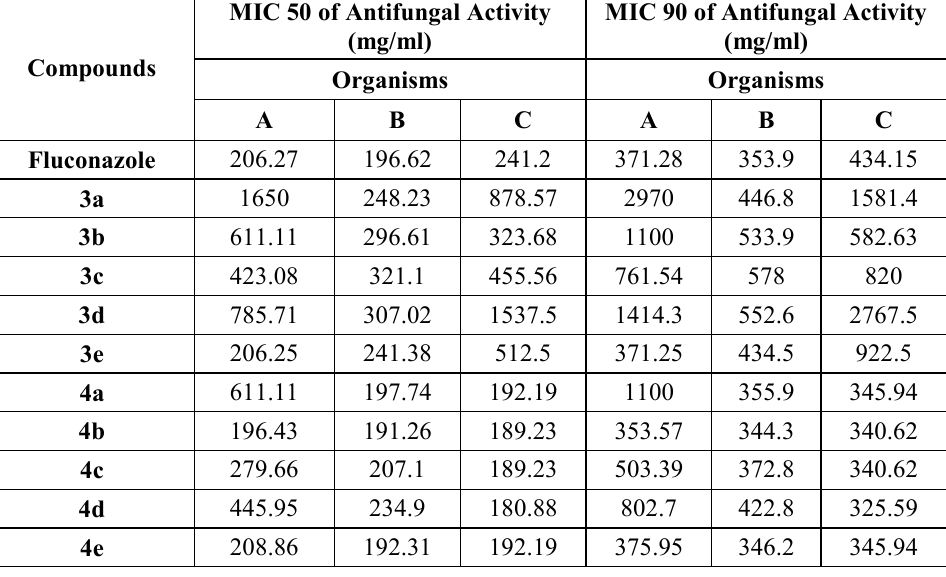
Table 5: Minimum inhibitory concentration (MIC) values (MIC50 & MIC90) of Most Potent compounds measured against three fungi